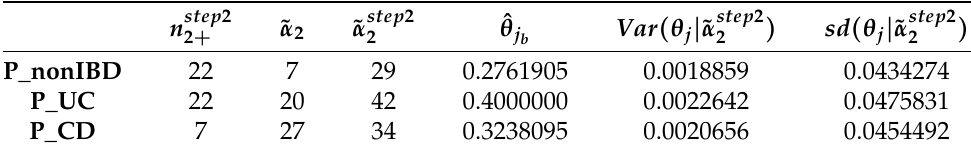
Table 32. Bayesian summaries Step 2 in A_UC .